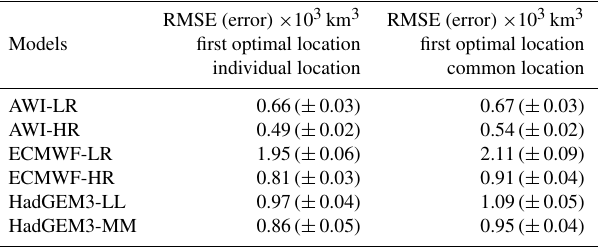
Table 2. Mean RMSEs (and associated SDs, error) from the 500 Monte Carlo realizations calculated between the original SIV anomalies and the SIV anomalies reconstructed by the SEM. We recall that in each Monte Carlo realization 70% of the data are ran- domly used for training the SEM, while 30% are used for calcu- lating the error. The middle column shows the values for the case where the predictors are extracted from the individual optimal loca- tions, while the right column shows the values found with predictors from the common optimal